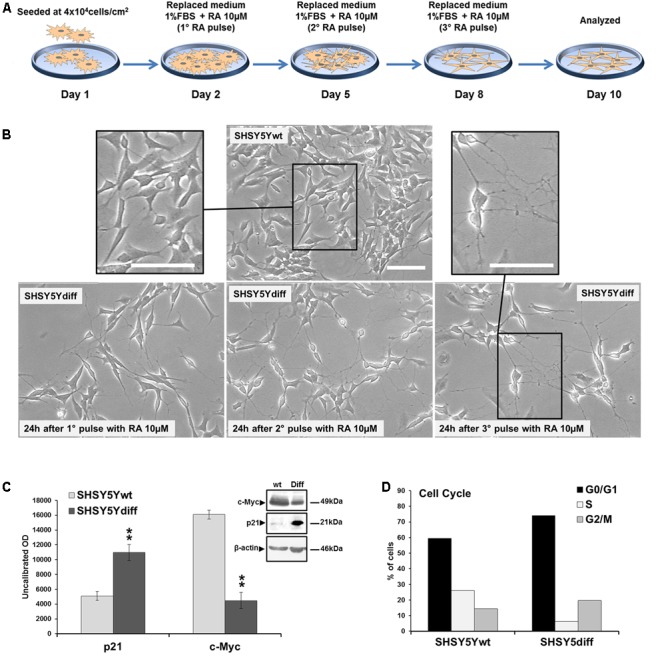
Phenotypical characterization of RA-differentiated SHSY5Y cells (SHSY5Ydiff). (A) Resuming scheme of the protocol used for the RA-induced differentiation of SHSY5Y cells. SHSY5Ydiff cells were obtained through a 9-days differentiation process. Cells were seeded at a density of 4 × 104 cells/cm2, and after 24 h (day 2), when the confluence of the monolayer was about 75%, were subjected to the 1st pulse with 10 μM RA, by replacing the culture medium with fresh medium containing RA and low serum (1% FBS). The 2nd and the 3rd pulses were performed at day 5 and 8, respectively, by replacing the medium to replenish RA, and at day 10 cells were analyzed or used for the experiments. (B) Phase contrast microscopy of SHSY5Ydiff cells 24 h after the 1st, 2nd, and 3rd pulses of 10 μM RA, showing the ongoing of neuronal differentiation with neurite outgrowth. Bar: 100 μm. (C) WB and densitometric analyses of the expression levels c-Myc and p21 in SHSY5Ydiff vs SHSY5Ywt. (D) Cytofluorimetric analysis of DNA content in SHSY5Ywt and SHSY5Ydiff cells. Values from densitometric analyses were normalized to β-actin. Significance SHSY5Ydiff vs SHSY5Ywt (Student’s t-test): ∗∗, p < 0.01; the mean ± SD; n = 4.